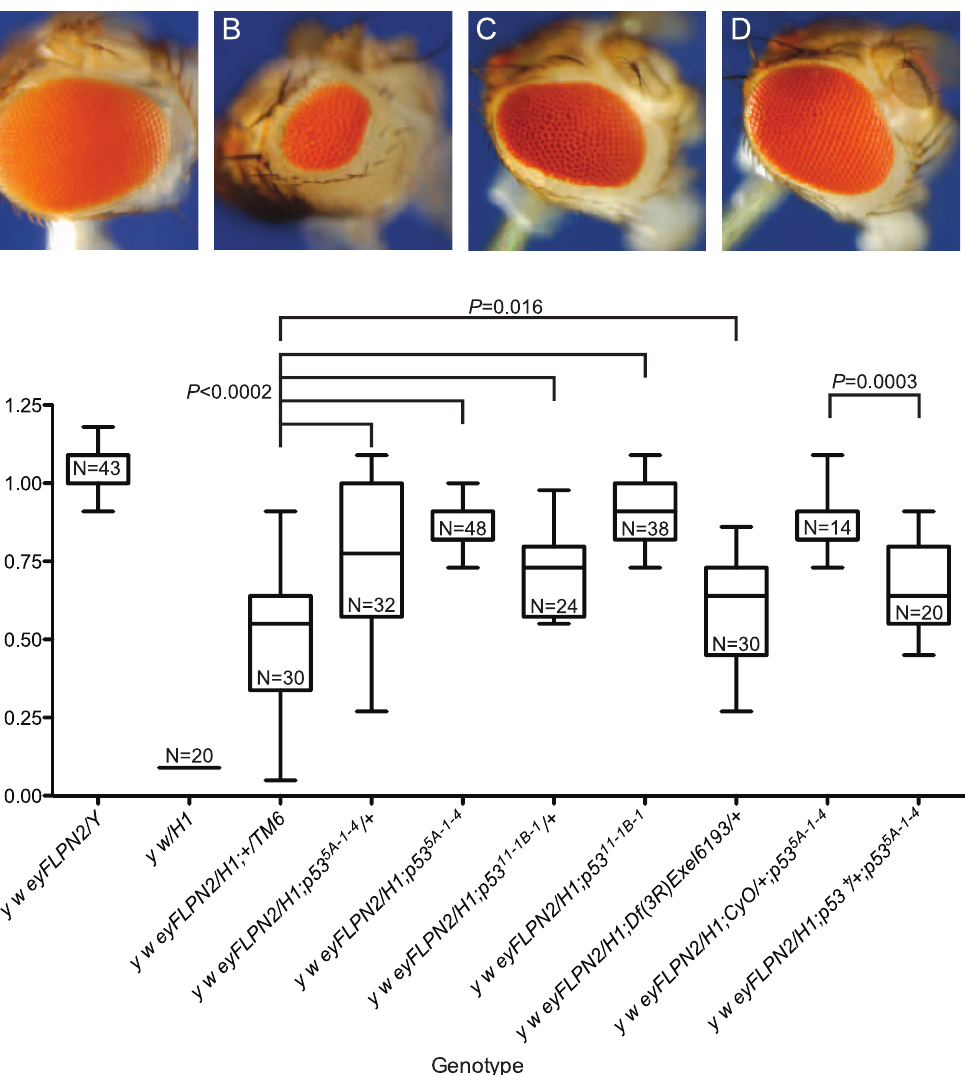
Figure 4. The role of p53 in the elimination of cells that have lost a telomere. Representative eyes are pictured: (A) w {eyFLP}16D/Y ; (B) w {eyFLP}16D/DcY ( H1 ); (C) w {eyFLP}16D/H1; p53 5A-1-4 /TM6, Ubx ; (D) w {eyFLP}16D/DcY ( H1 ) ; p53 5A-1-4 . (E) BARTL results for various p53 mutant and wildtype combinations. The first two whisker plots are controls and are repeated here (from Figure 2) for ease of comparison. All sizes are presented after normalization to wild type. Significance levels for critical comparisons are